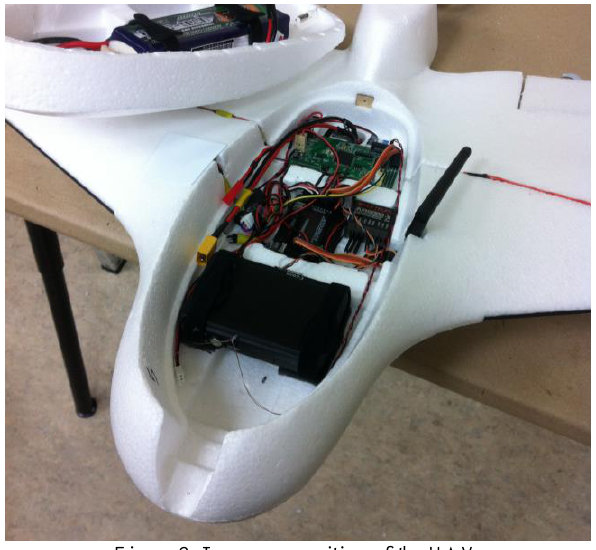
Figure 2. Inner composition of the